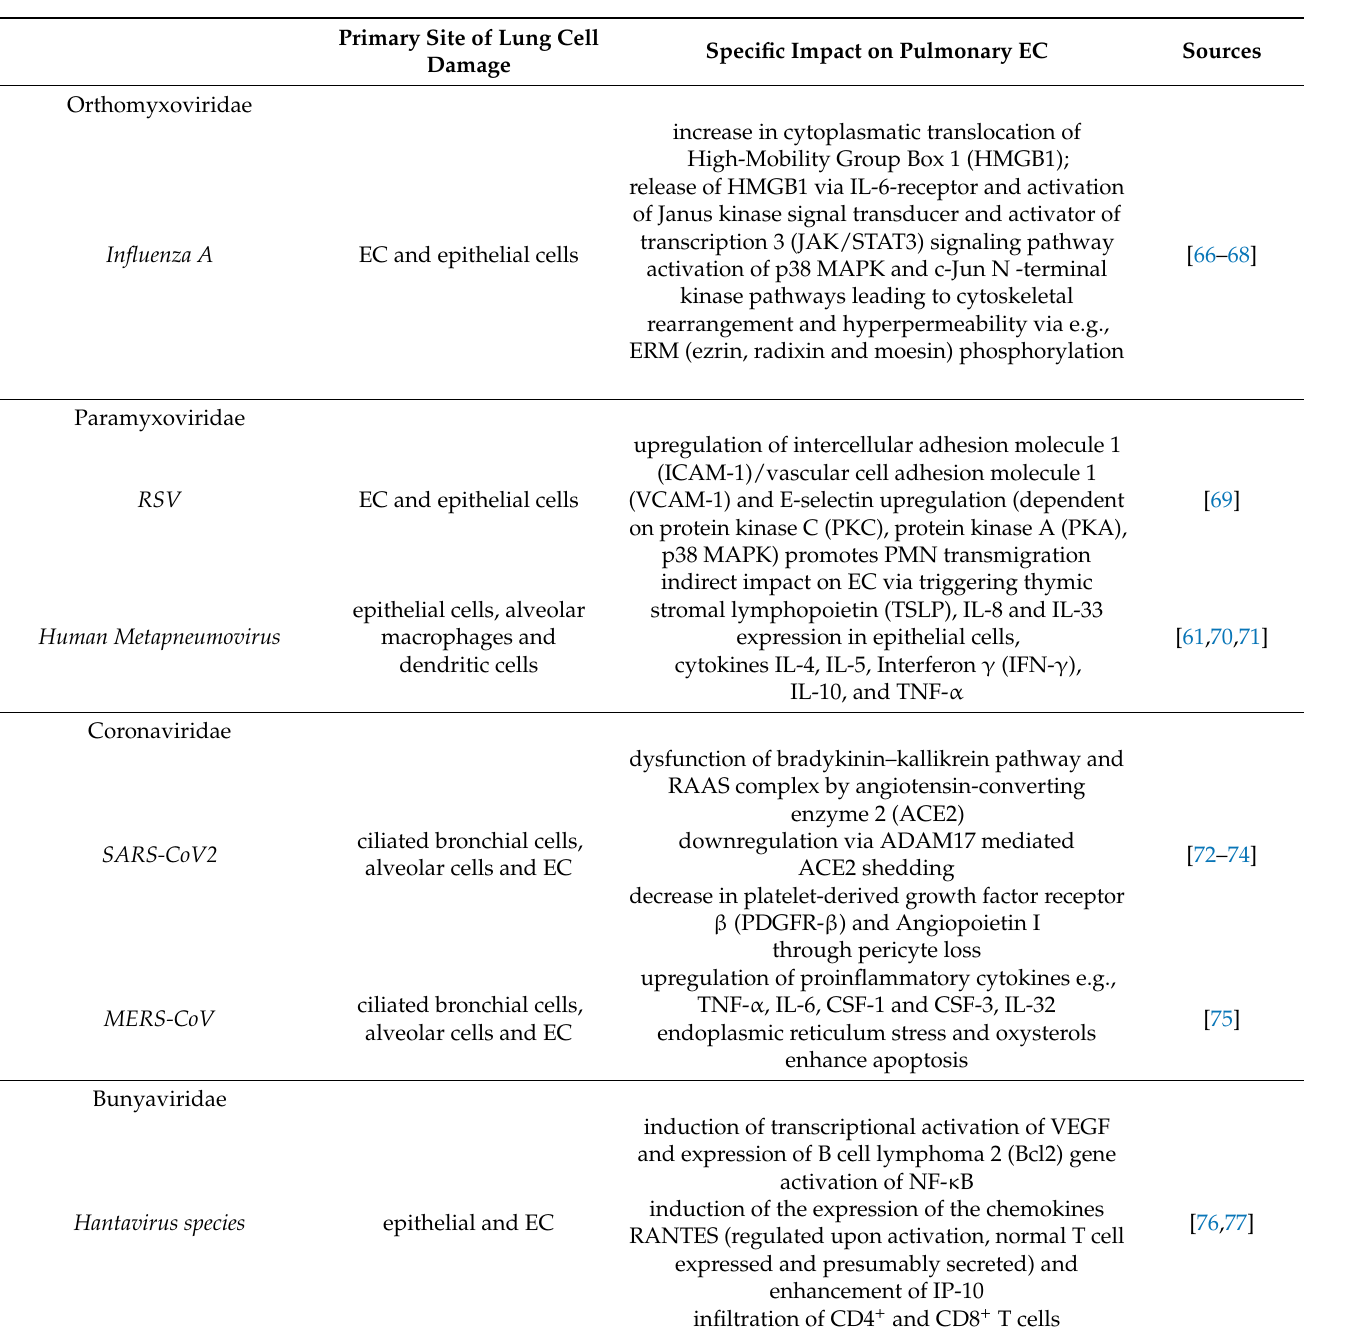
Table 2. Influence of selected virus species on pulmonary endothelial